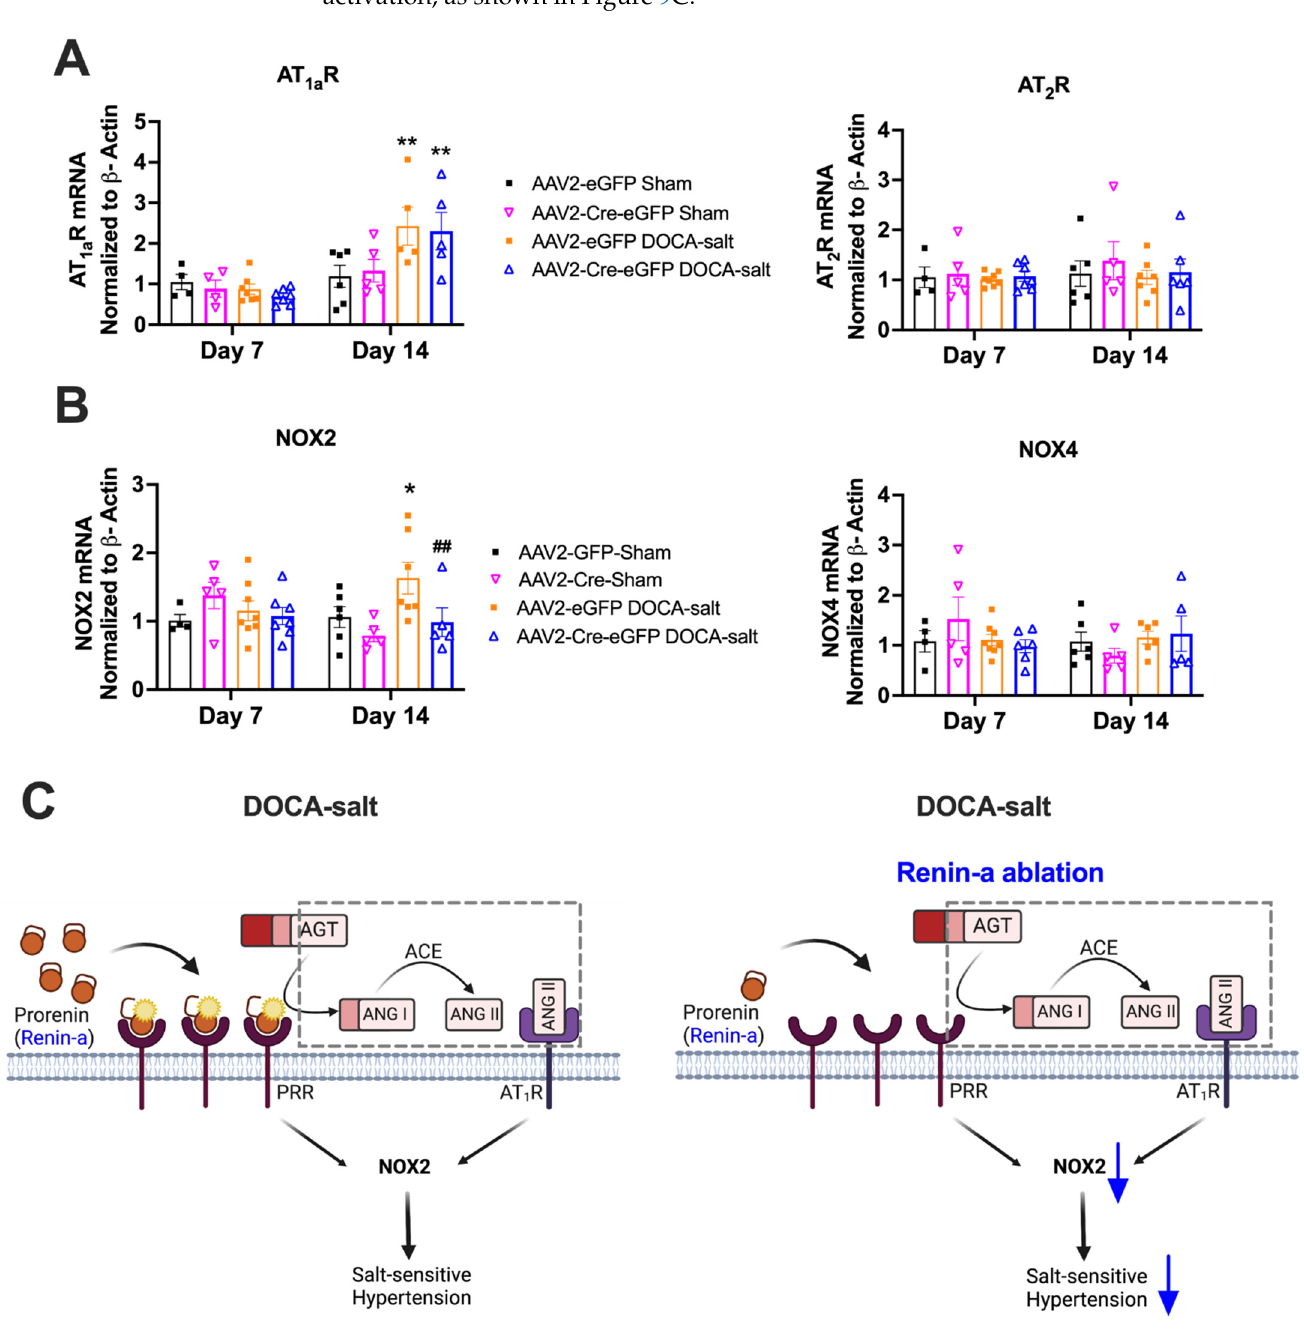
Figure 9. Renin-a deletion in the SFO prevents upregulation of NOX2 during DOCA-hypertension. mRNA expression of target genes measured in SFO samples from DOCA-Salt or Sham mice on days 7 and 14 of treatment. ( A ) Quantitative PCR analysis of mRNA expression of Ang II receptors (AT 1a R and AT 2 R) and ( B ) NAD(P)H oxidases (NOX2 and NOX4). ( C ) Mechanistic hypothesis for the effect of SFO ablation of renin-a on salt-sensitive hypertension (illustration created using Biorender); pathways in dotted gray square were not directly tested in this study. * p < 0.05, ** p < 0.01 versus baseline AAV2-eGFP Sham; ## p < 0.01 versus AAV2-eGFP DOCA-salt (one-way ANOVA with Fisher’s LSD test). Abbreviations: AT 1a R, angiotensin II type 1a receptor; AT 2 R, angiotensin II type 2 receptor; NOX2, NADPH oxidase isoform 2; NOX4, NADPH oxidase isoform 4; SFO, subfornical